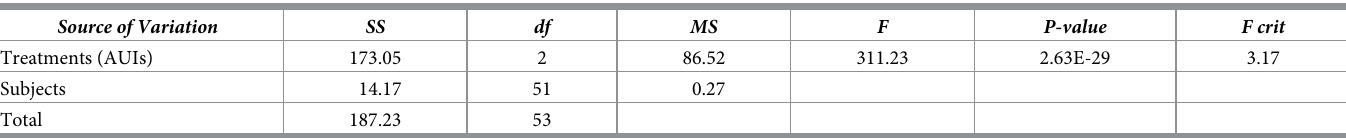
Table 24. One-way ANOVA—Viewpoint #8. Source of Variation